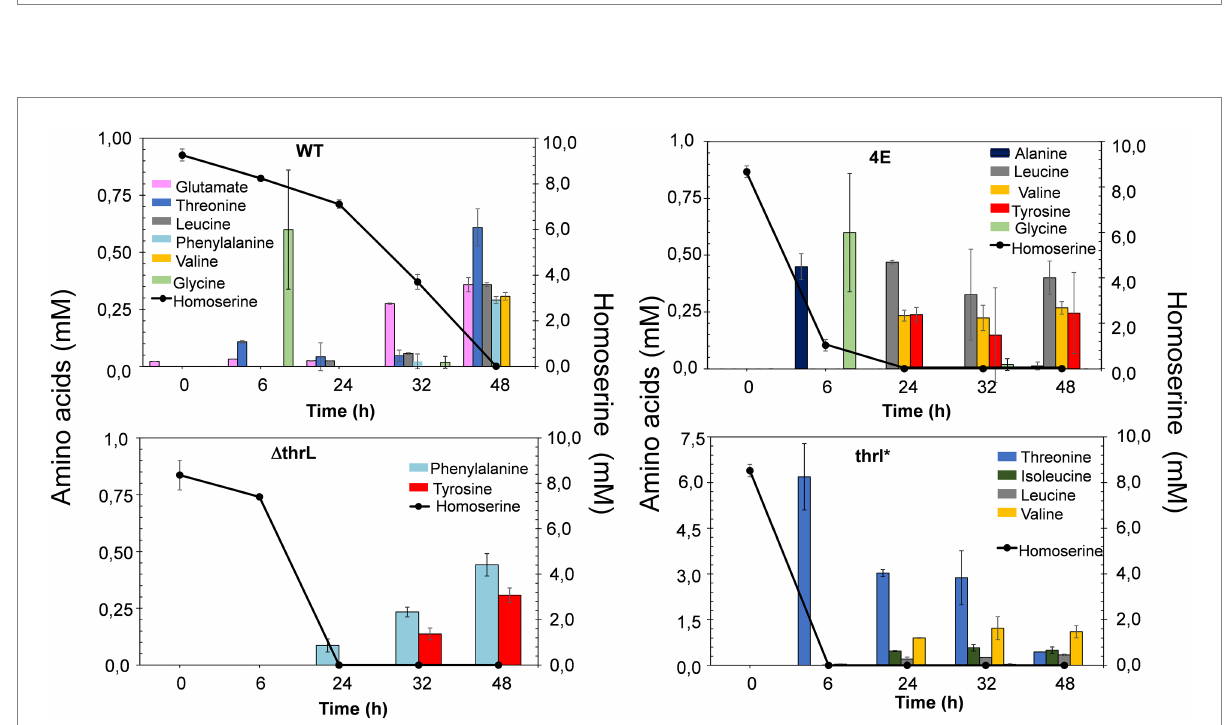
FIGURE 5 Exometabolome in MG1655 (WT), MG1655 deleted for thrL ( Δ thrL), MG1655 in which thrL was replaced by thrL* (thrL*) and homoserine-adapted strains (4E) during growth in M9 medium buffered at pH 7.0 by MOPS 100 mM and containing 2% (w/v) glucose and in the presence of 10 mM L-homoserine. Data are the mean of three biological replicates, with SD represented by a bar on the histograms. Notice the difference in the scale for amino acids level in the exometabolome pattern of strain thrL*